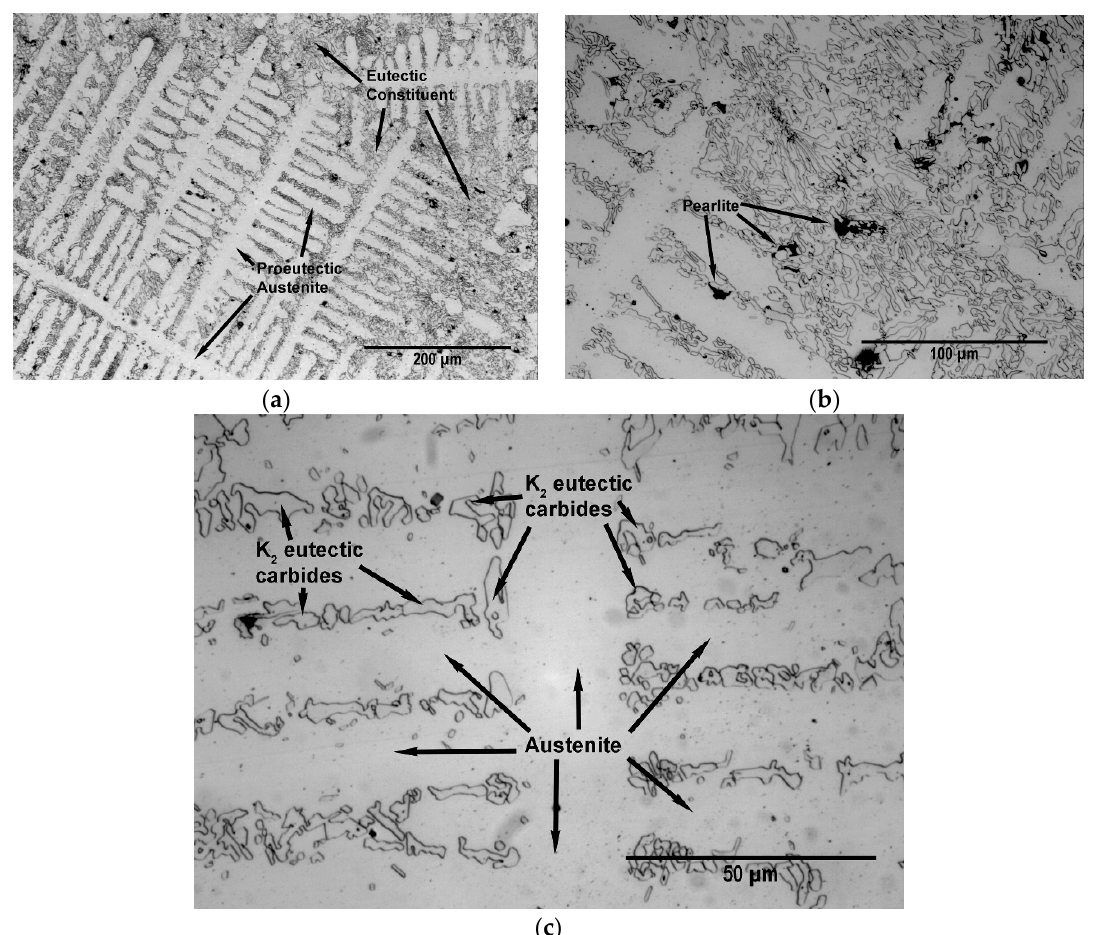
Figure 1. As-castmicrostructure: ( a ) × 200magnification; ( b ) × 500magnification; ( c ) × Figure 1. As-cast microstructure: ( a ) ×200 magnification; ( b ) ×500 magnification; ( c ) ×1000 magnification.